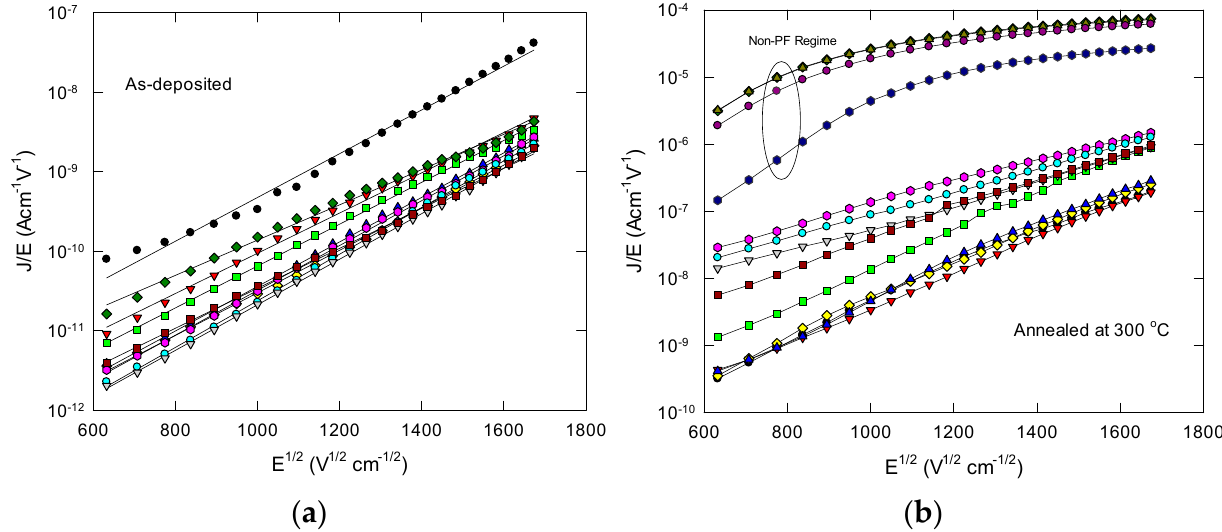
Figure 4. Poole–Frenkel plot of the current-voltage characteristic variability of W/La 2 O 3 /Si capacitors: ( a ) as-deposited; and ( b ) annealed at 300 °C for 30 min.